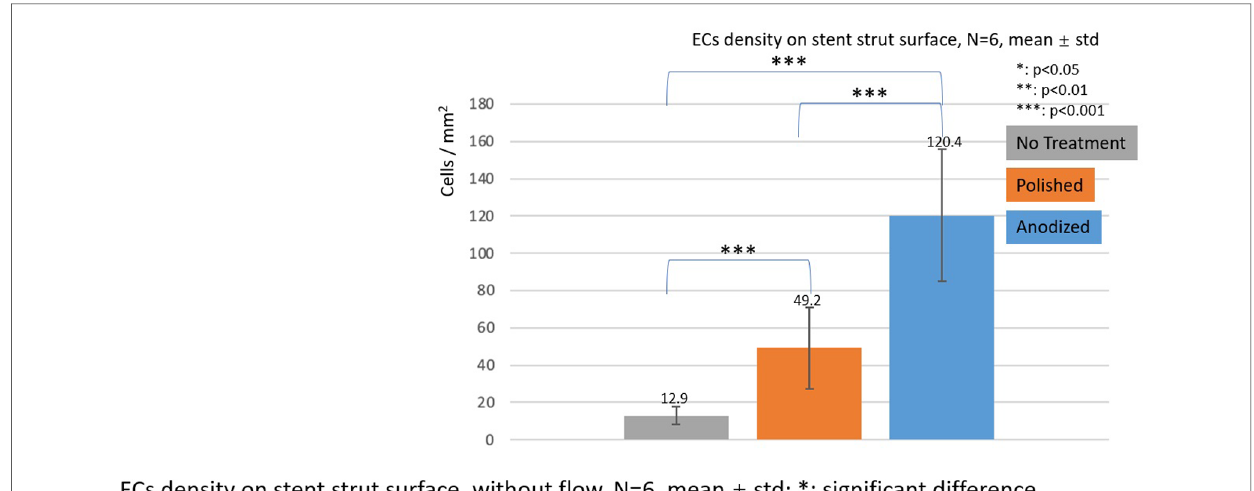
FIGURE 7 ECs density on stent strut surfaces, without fl ow 24-h, N =6, mean± std; T -test was performed to compare the signi fi cant difference (* p < 0.05; ** p < 0.01; *** p <